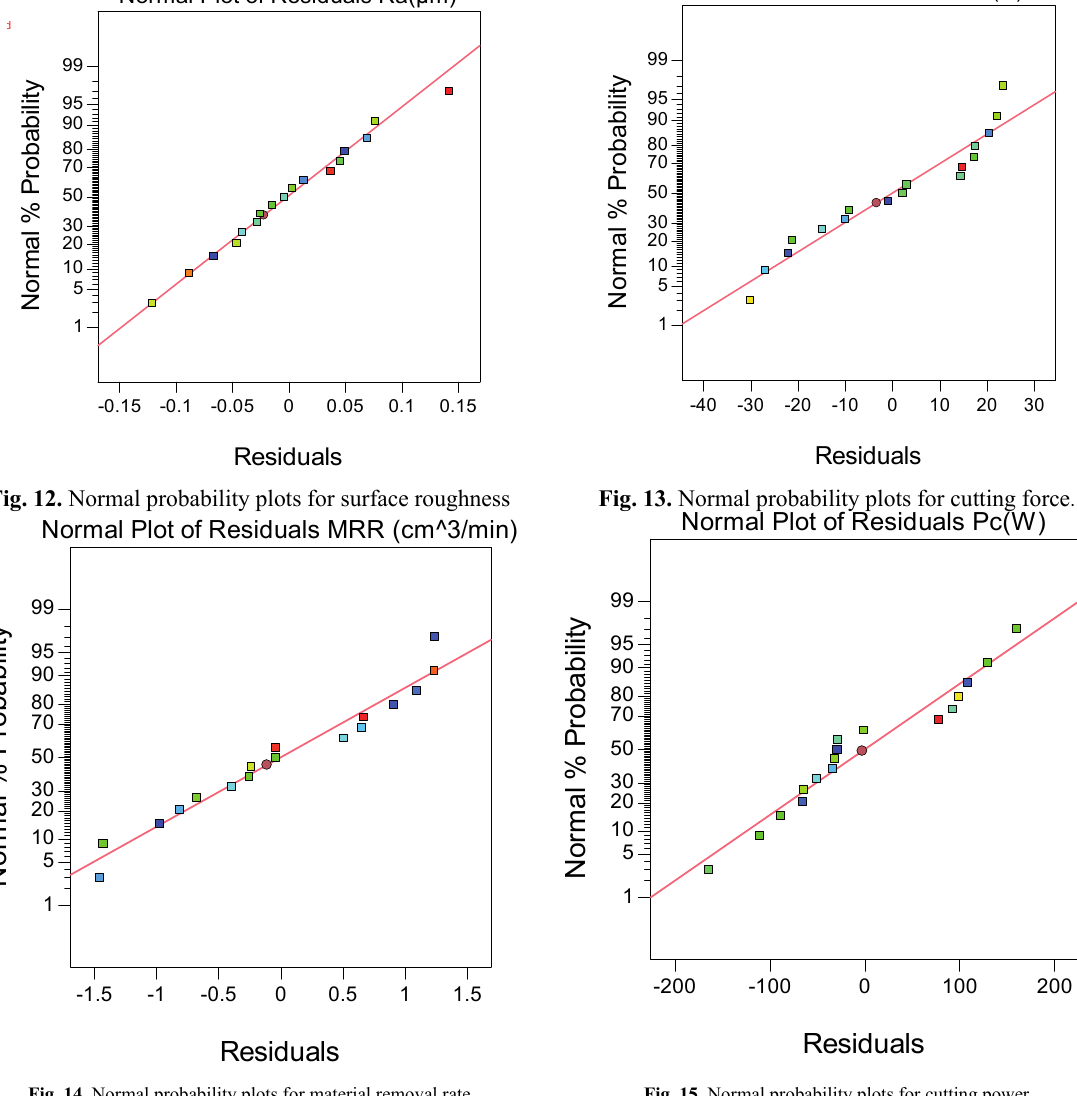
Fig. 14. Normal probability plots for material removal rate Fig. 15. Normal probability plots for cutting